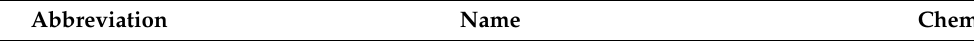
Table 9. Chemical structures of the PILs evaluated as CIs.